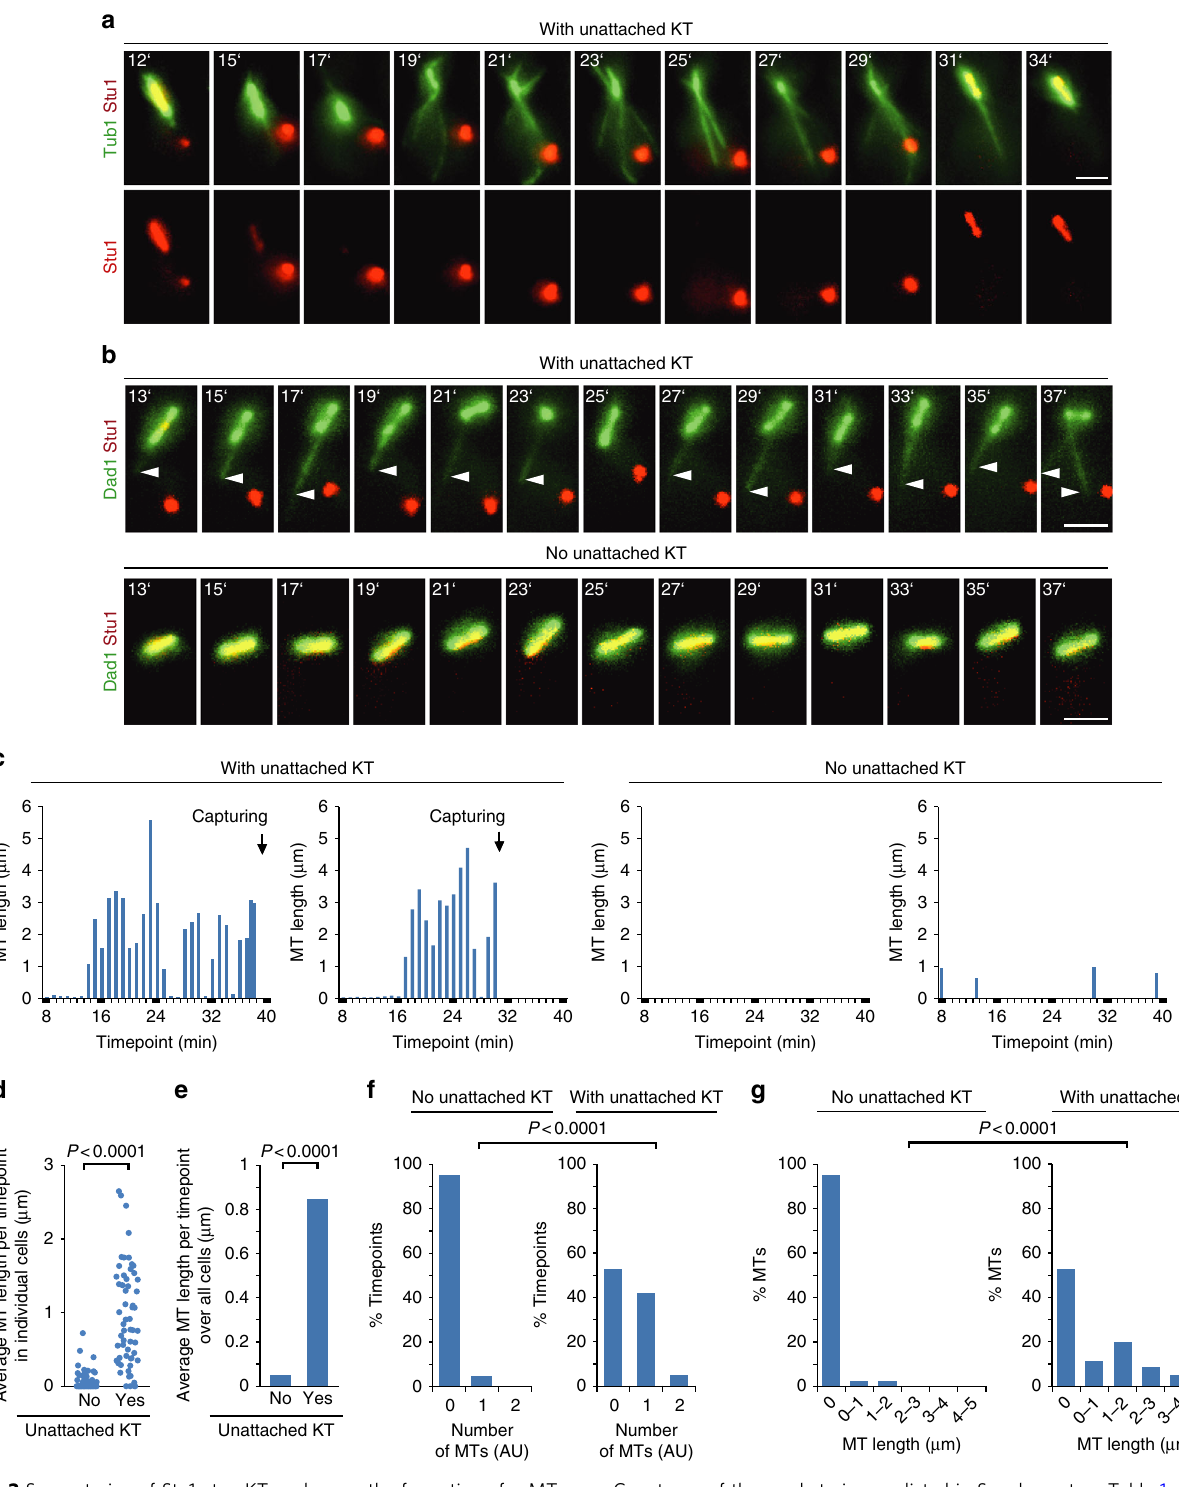
Fig. 3 Sequestering of Stu1 at uaKTs enhances the formation of nrMTs. a – g Genotypes of the used strains are listed in Supplementary Table 1. a Sequestering of Stu1 at uaKTs results in spindle collapse and drives the formation of non-spindle MTs. Capturing of the uaKT allows the relocalization of Stu1 to the spindle region and spindle stabilization. Cells were analyzed at the indicated timepoints after KT reactivation as described in Fig. 2. MTs were visualized via GFP-Tub1. Bar, 2 µ m. b Sequestering of Stu1 at uaKTs drives the formation of nrMTs. Experiment as in a , but revealing nuclear MTs via Dad1- GFP localization. Arrowheads indicate nrMTs. c Occurrence and length of nrMTs for four representative cells observed as in b . d – g Cells were observed as in b and the number and length of nrMTs were determined. Cells were analyzed from the timepoint when the uaKT had sequestered 55 – 75% of the total localized Stu1 to the timepoint before the uaKT interacted with a capturing MT or if the uaKT was not captured till the end of the fi lm. Cells without an uaKT were analyzed over 15 timepoints. Statistics, see Supplementary Table